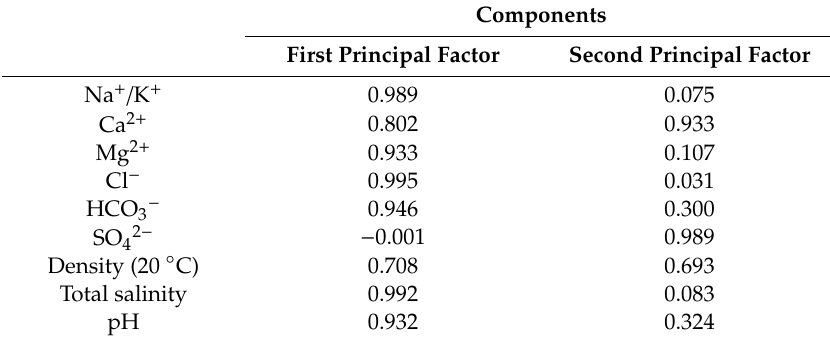
Table 3. Component matrix.